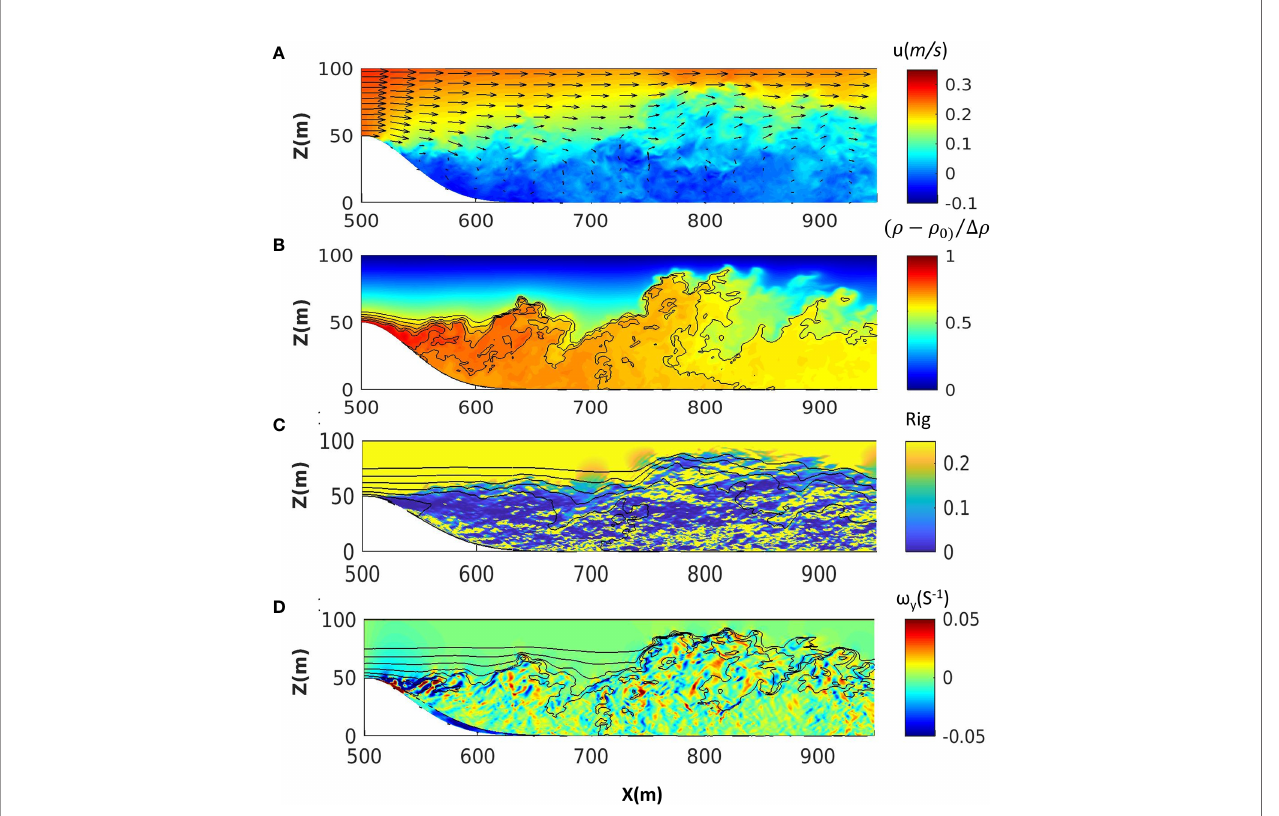
FIGURE 4 | Model simulations ( Fr =0.25) of (A) streamwise velocity at the central transect of the spanwise direction, (B) normalized density ( r – r 0 )/ Dr , where Dr is the density difference between the top and bottom boundary and r 0 is the background density, (C) the gradient Richardson number calculated based on the spanwise averaged density gradient and velocity gradient (the spanwise averaged normalized density is shown as contour lines), and (D) the instantaneous spanwise vorticity w _y= ∂ _z U+ ∂ _x W (the instantaneous normalized density is shown as contour lines). The two-dimensional topography is parameterized by a Gaussian